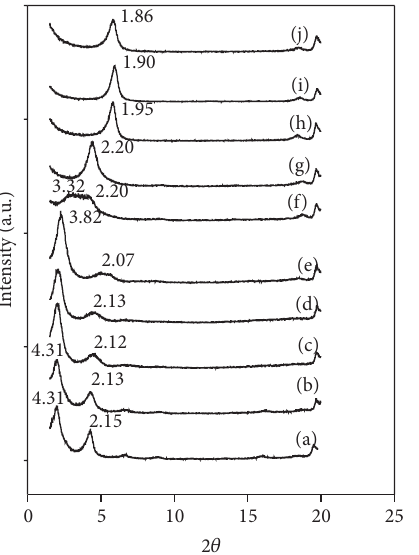
Figure 5: In situ XRD patterns of PVP/C16TMA-Mt composite calcined at different temperatures. (a) 25, (b) 100, (c) 150, (d) 200, (e) 205, (f) 215, (g) 250, (h) 300, (i) 350, and (j) 425 ( ∘ C).